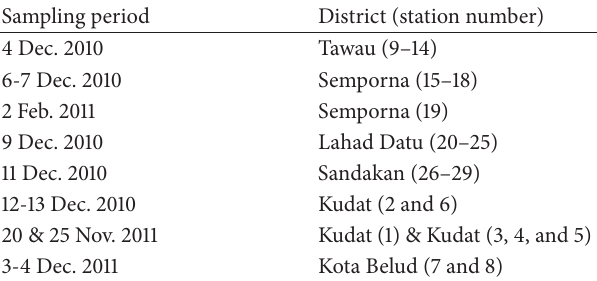
Table 1: Sampling period according to